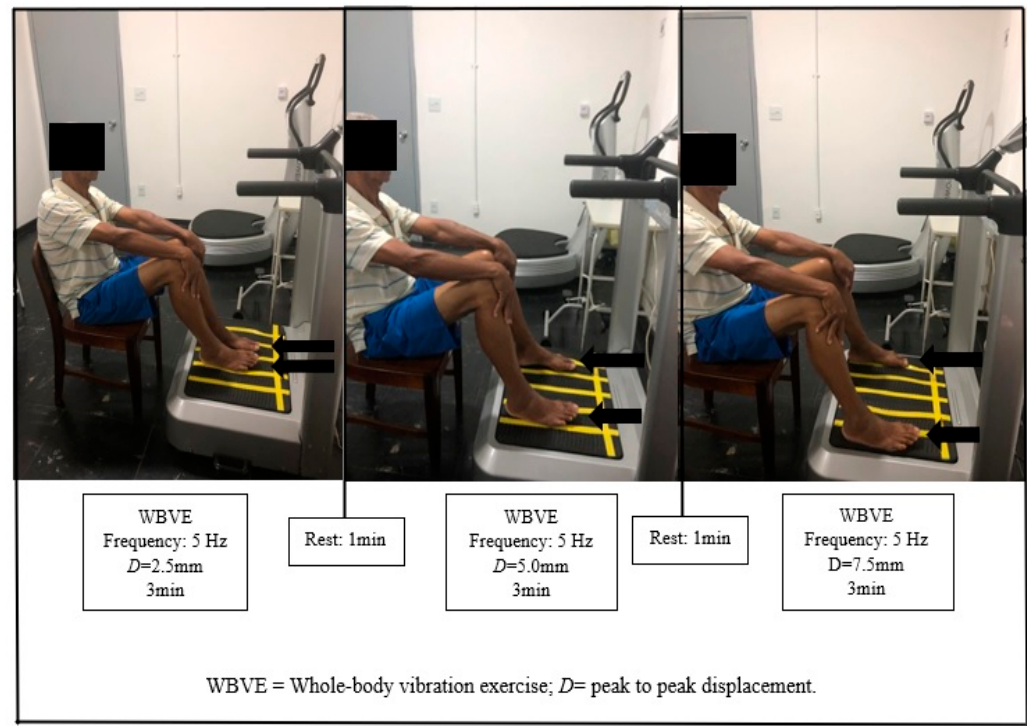
Figure 3. Whole-body vibration exercise intervention.